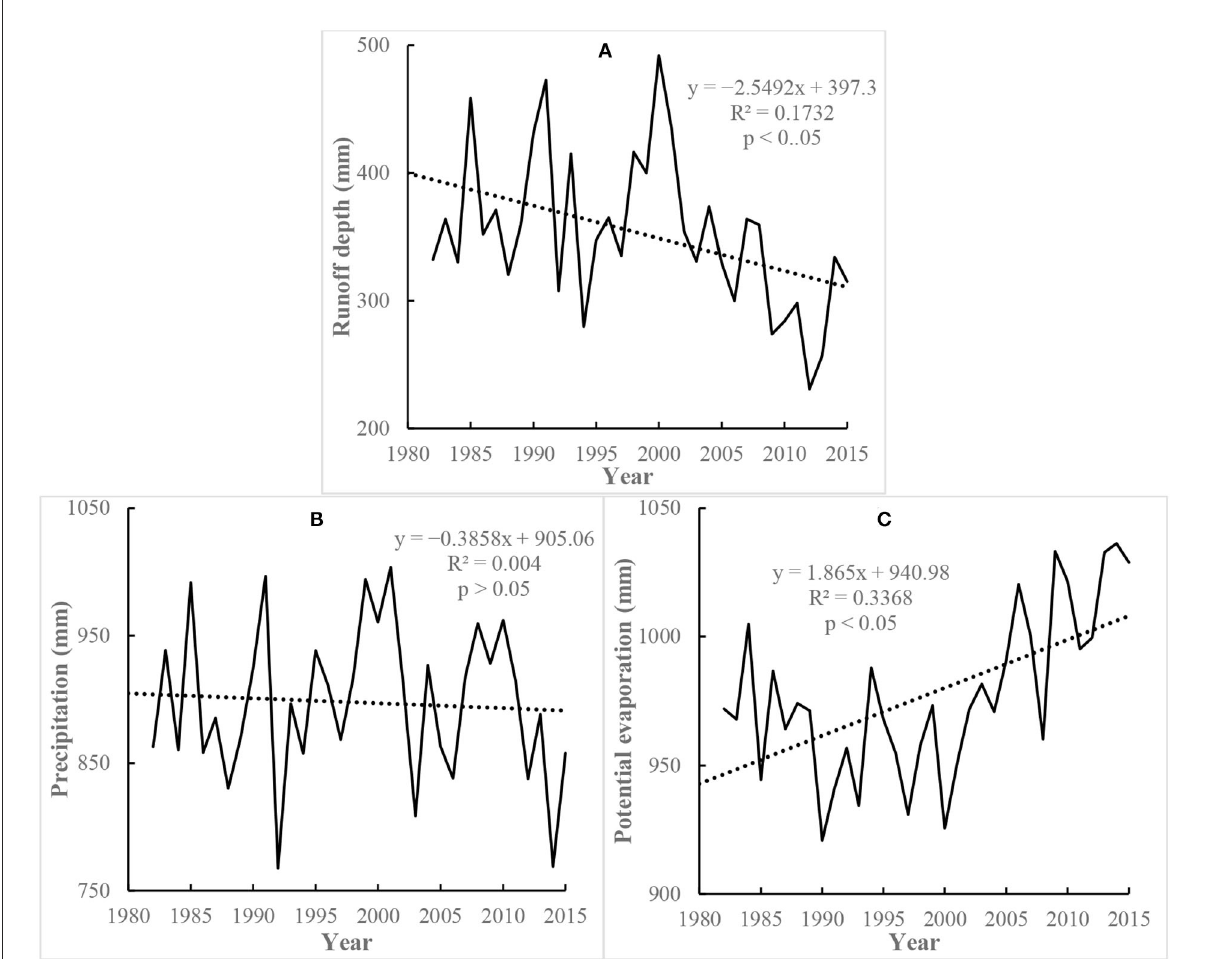
FIGURE2 Interannual variation of runoff depth (A) , precipitation (B) , and potential evaporation (C) in the Lancang River Basin (LCRB) from 1982 to 2015.